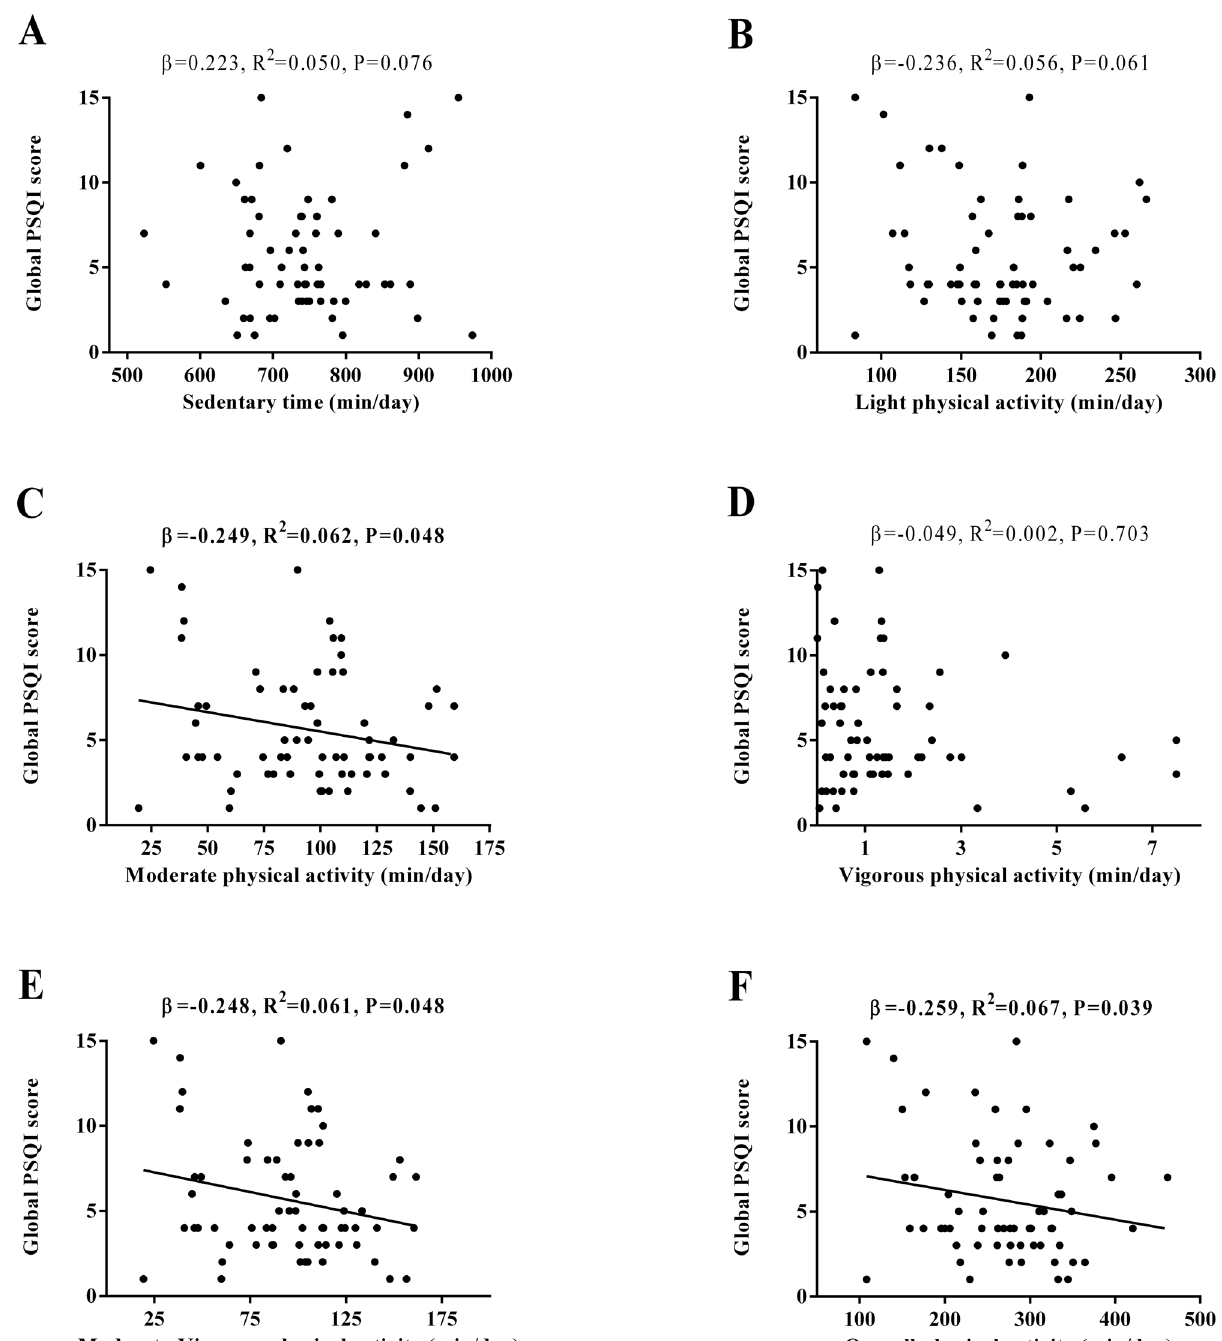
Figure 2. Association of physical activity levels with subjective sleep quantity and quality in sedentary middle-aged adults. β (standardized regression coefficient), R 2 , and P from a simple linear regression analysis. Significant P values (≤ 0.05) are in bold. PSQI Pittsburgh Sleep Quality